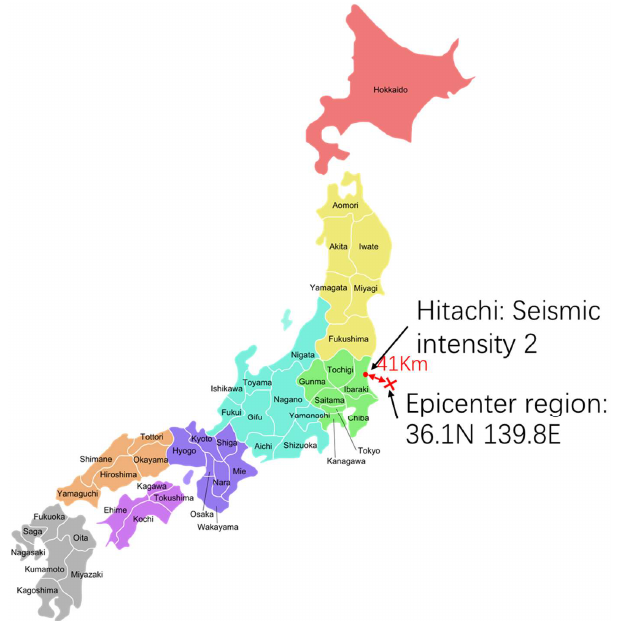
Figure 9. The maximum seismic intensity in Hitachi and the distance between Hitachi and the epicenter region off the coast of Ibaraki